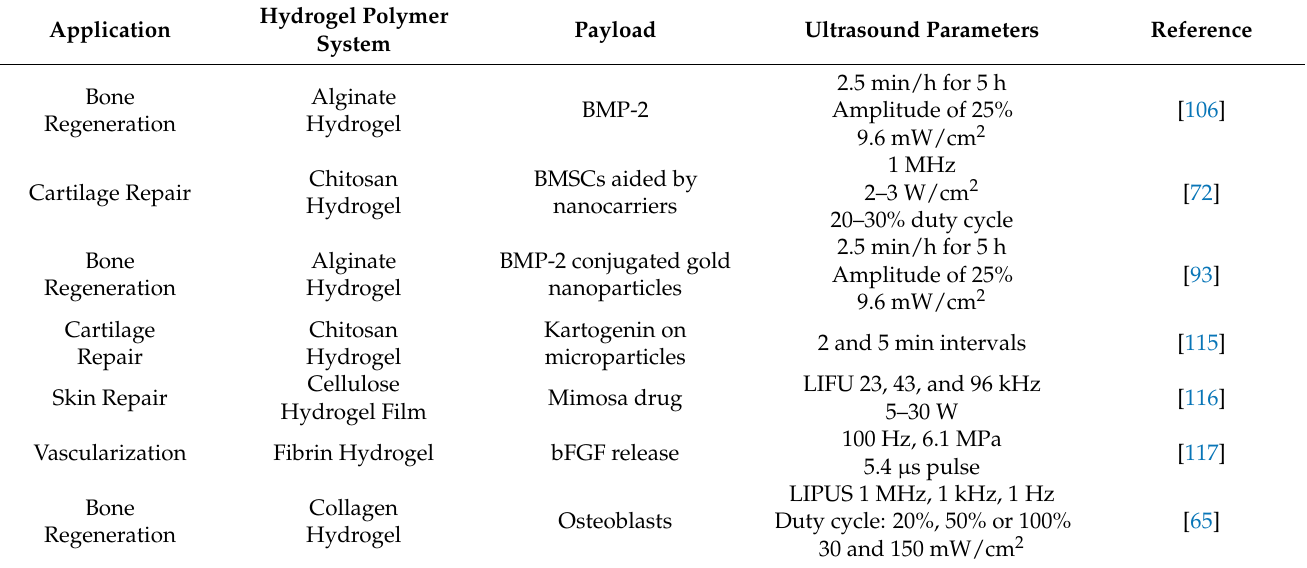
Table 1. Characteristics of ultrasound-responsive hydrogels for tissue engineering applications.